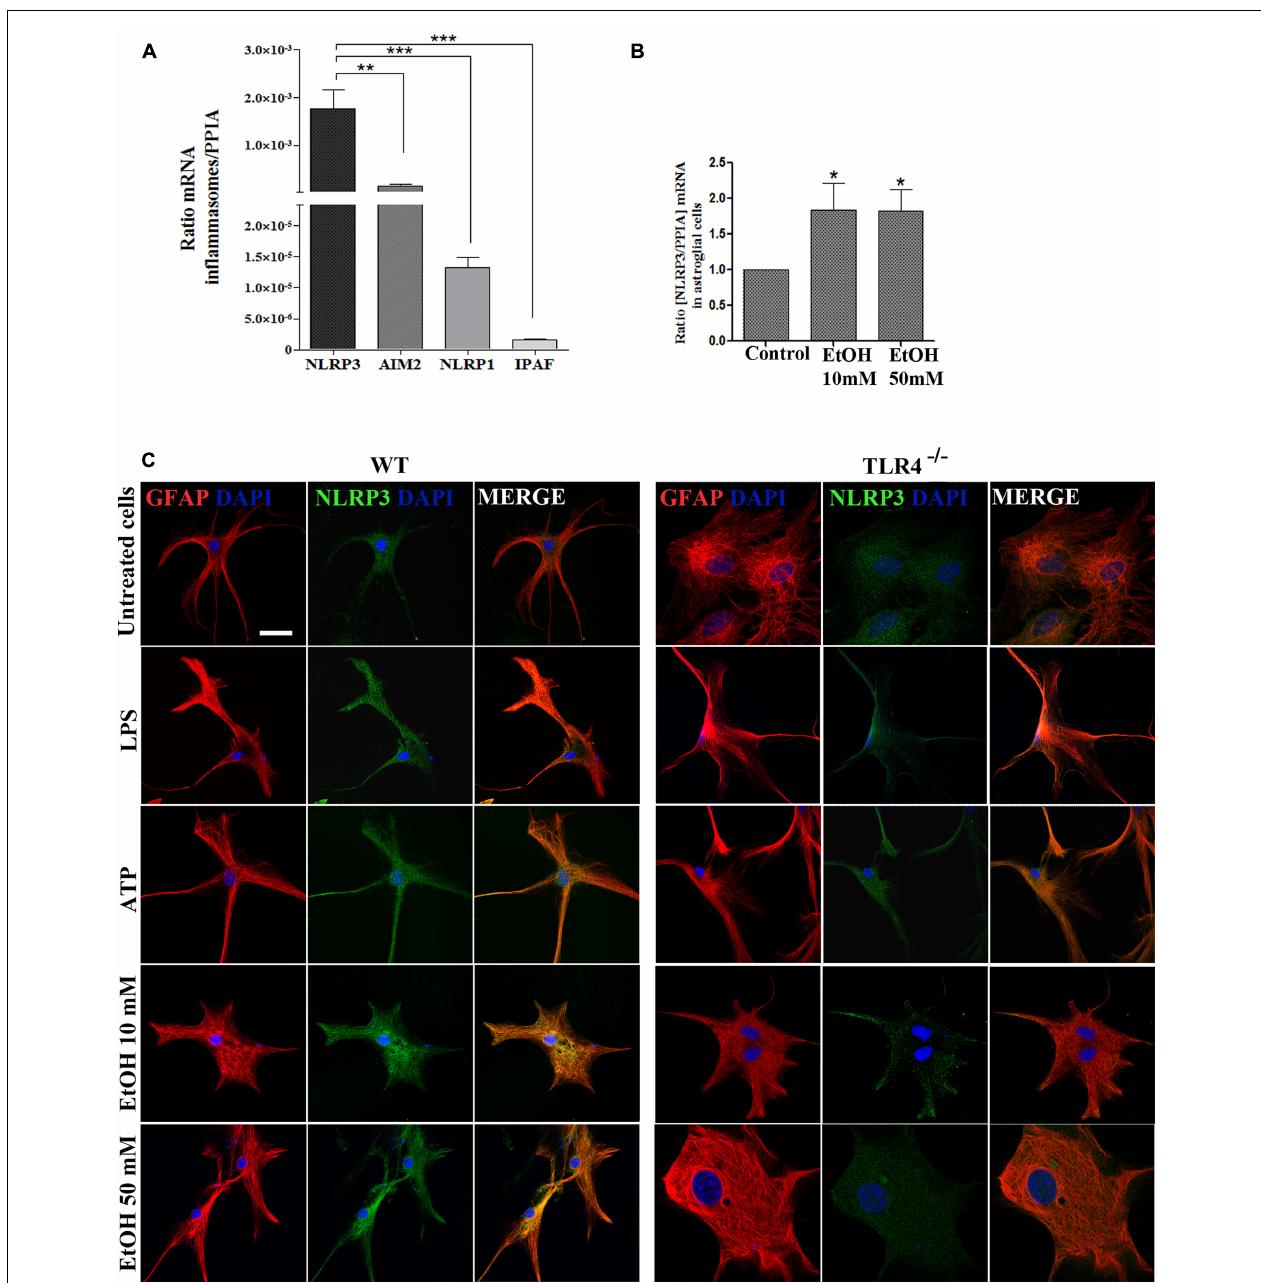
experiments and ratios were normalized with the PPIA housekeeping gene. Bars represent the [mean ± SEM]. * p < 0.05, ** p < 0.01, *** p < 0.001 (Mann–Whitney U non-parametric test or a Student’s t -test). (C) Immuno- fluorescence of NLRP3 (green) and GFAP- (red) co-localization in the astrocytes fromTLR4 andTLR4-knockout mice. Scale bar 20 μ